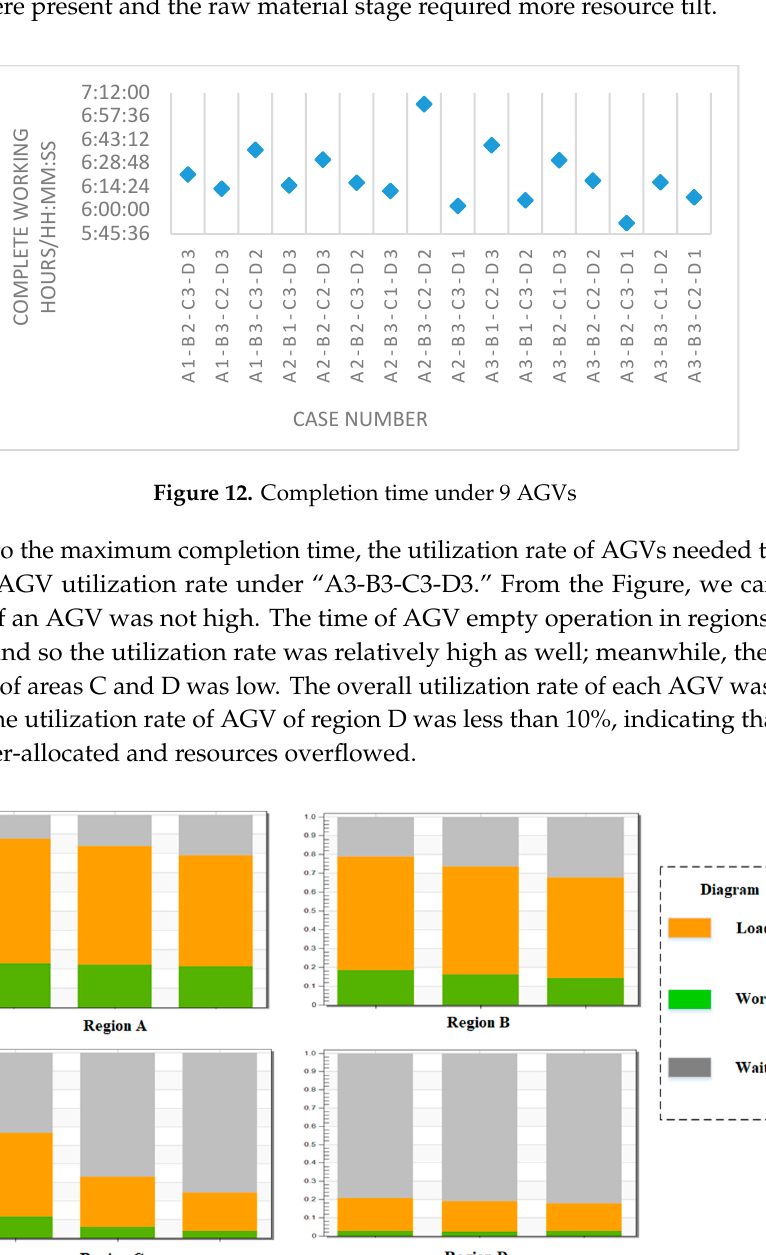
Table 11. Cross-regional independent resource pool simulation results